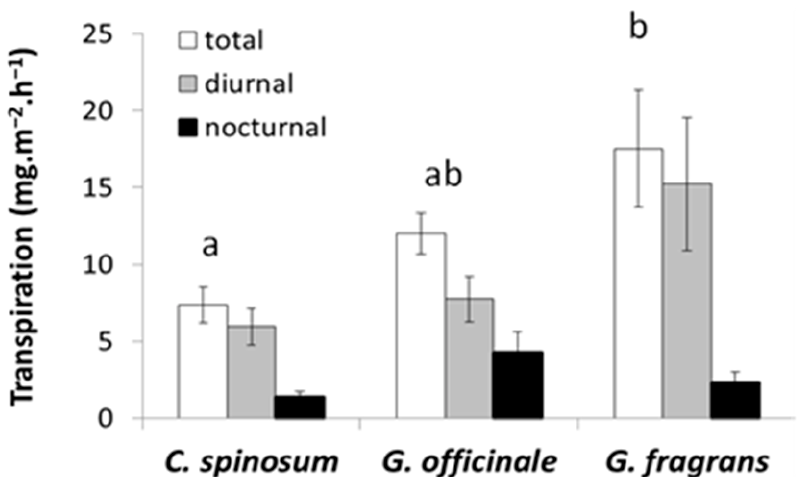
Figure 8. Diurnal, nocturnal and total transpiration rates per unit of leaf area in the three species. Bars represent the standard error. The superscript letters designate species with significantly different total transpiration rates according to the ANOVA and Tukey’s test ( p <